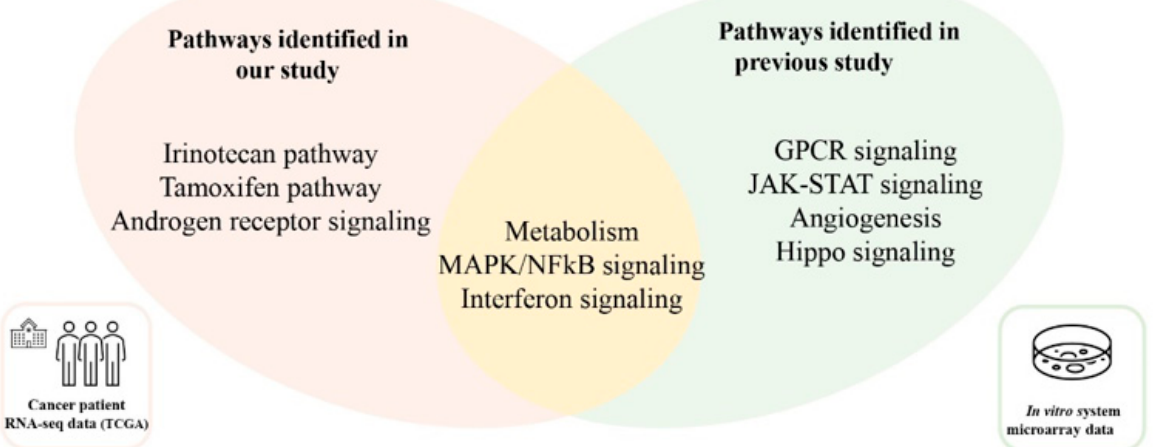
Figure 3. Comparison of pathways found from two studies on ETV4 -related changes. Pathway analysis was performed by CPDB. This study used 393 genes correlated with ETV4 expression, and the previous study used 774 genes altered by overexpression or knock-down of ETV4 [18].